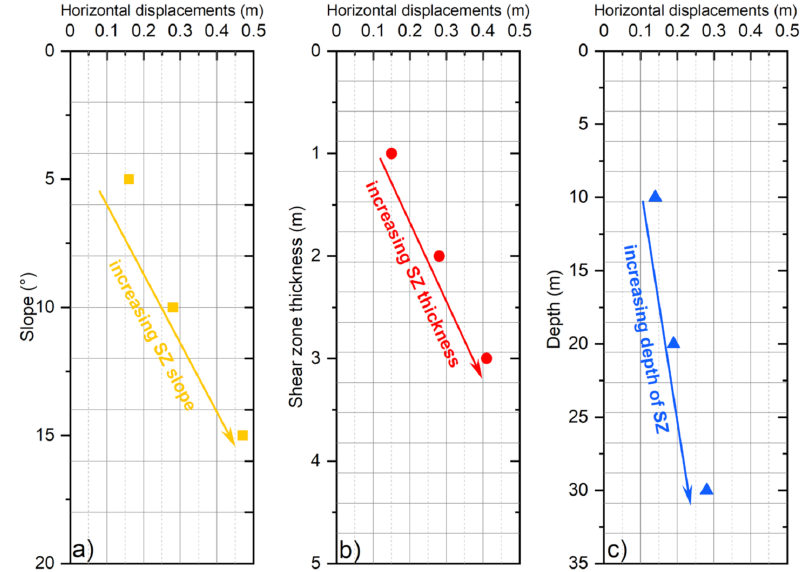
Figure 10. The sensitivity analysis results varying ( a ) shear zone slope, ( b ) shear zone thickness and ( c ) shear zone